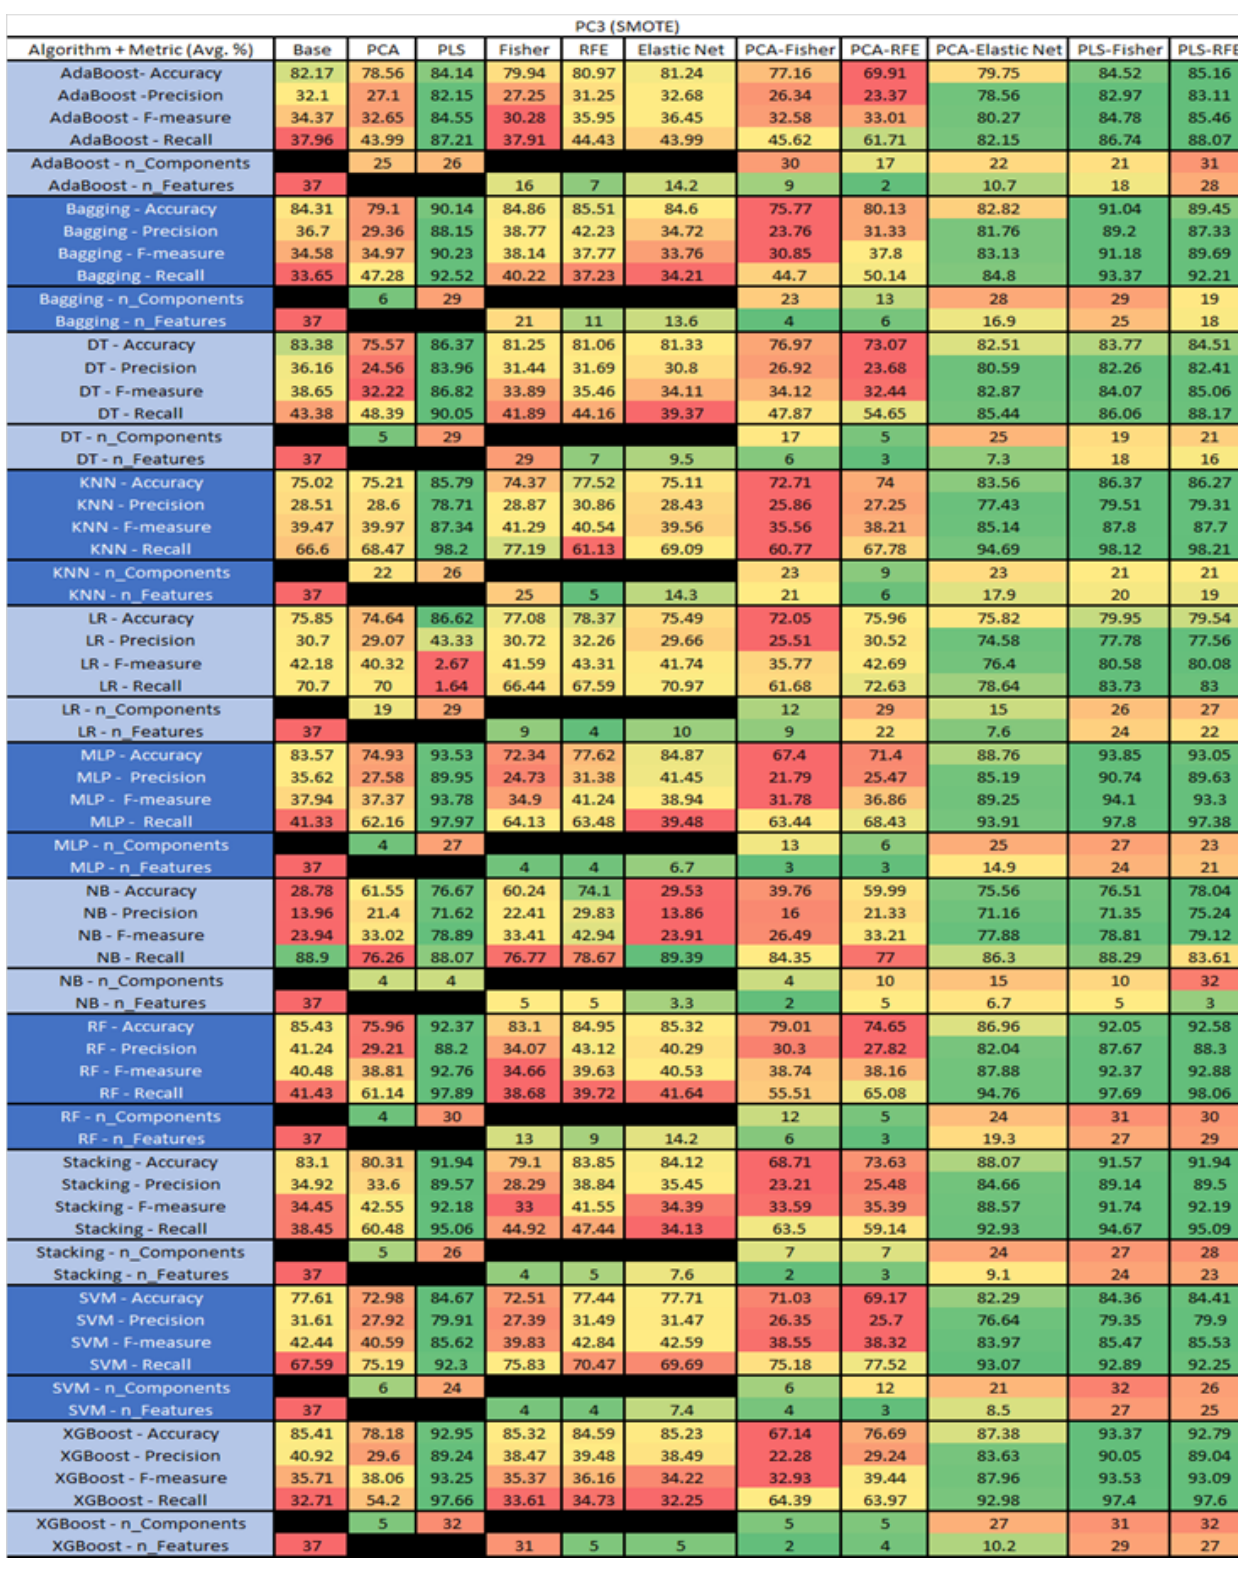
Figure 45. PC3 SMOTE NASA MDP Results Data